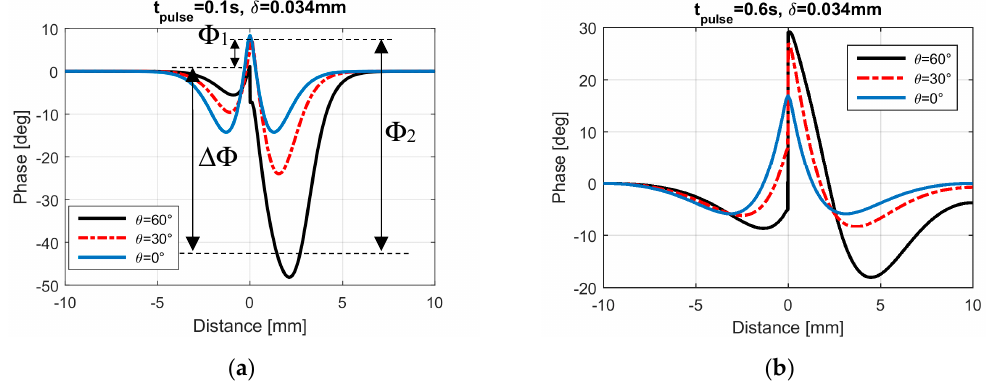
Figure 14. Phase around cracks with the same depth d = 1 mm, but with different inclination angles simulated with the simu.2 model for ferro-magnetic steel properties. ( a ) Calculated for a 0.1 s pulse length and ( b ) for a 0.6 s heat duration.